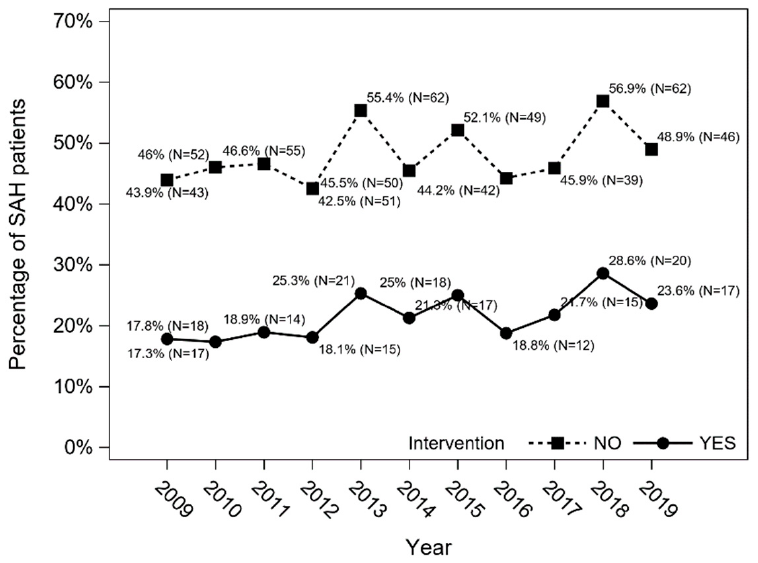
Figure 5. In-hospital mortality in SAH patients treated conservatively (no intervention) and in those who underwent intervention (Cochran–Armitage trend test with Holm–Bonferroni correction: p = 0.165 and p = 0.147, respectively).